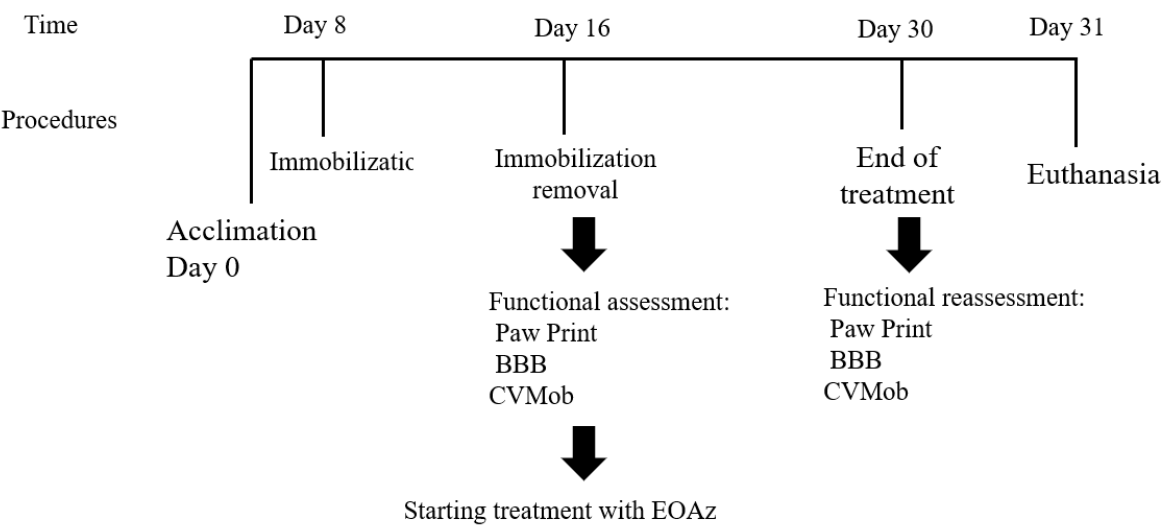
Figure 2. Scheme of the study timeline. The timeline displays the time in days and the procedures that took